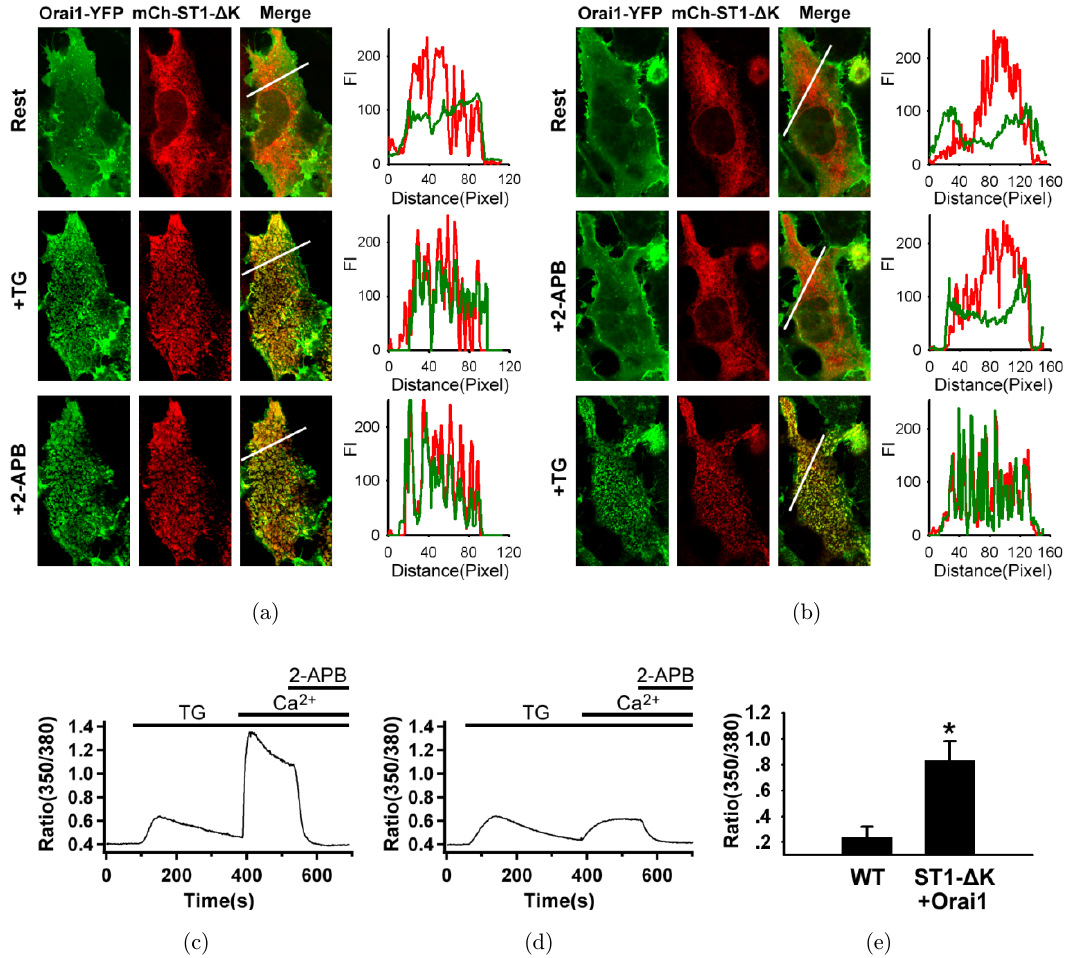
Fig. 5. 2-APB failed to reverse or prevent STIM1- Δ K localization in near plasma membrane puncta in HEK293 cells co-expressing mCherry-STIM1- Δ K and Orai1-eYFP. (a) After Ca 2 þ store depletion, mCherry-STIM1- Δ K co-accumulates with Orai1 in puncta (middle); 50 (cid:1) M 2-APB failed to reverse STIM1- Δ K localization in near plasma membrane puncta in HEK293T cells (bottom). (b) Confocal imaging was carried out on cells expressing mCherry-STIM1- Δ K with Orai1-eYFP, in which 50 (cid:1) M 2-APB was added 5 min prior to store depletion with TG. After pretreatment of cells with 50 (cid:1) M 2-APB, mCherry-STIM1- Δ K redistributed into puncta and clustered Orai1 after depletion. (c) SOCE was measured in HEK293 cells co-expressing STIM1- Δ K and Orai1 using TG (2 (cid:1) M). TG was applied under Ca 2 þ -free conditions for 5 min to deplete ER Ca 2 þ stores followed by addback of 1.8 mM Ca 2 þ to assess SOCE. Traces indicate the changes in the ratio of Fura-2 °uorescence intensities over time in selected cells. (d) SOCE was measured in wild-type HEK293 cells in the same experimental paradigm as (c). (e) Averaged peak Ca 2 þ elevation by re-addition of 1.8 mM Ca 2 þ after store depletion from experiments carried out as described in (c) ( n ¼ 22) and (d) ( n ¼ 23). Signi¯cances of the t -test are labeled on the